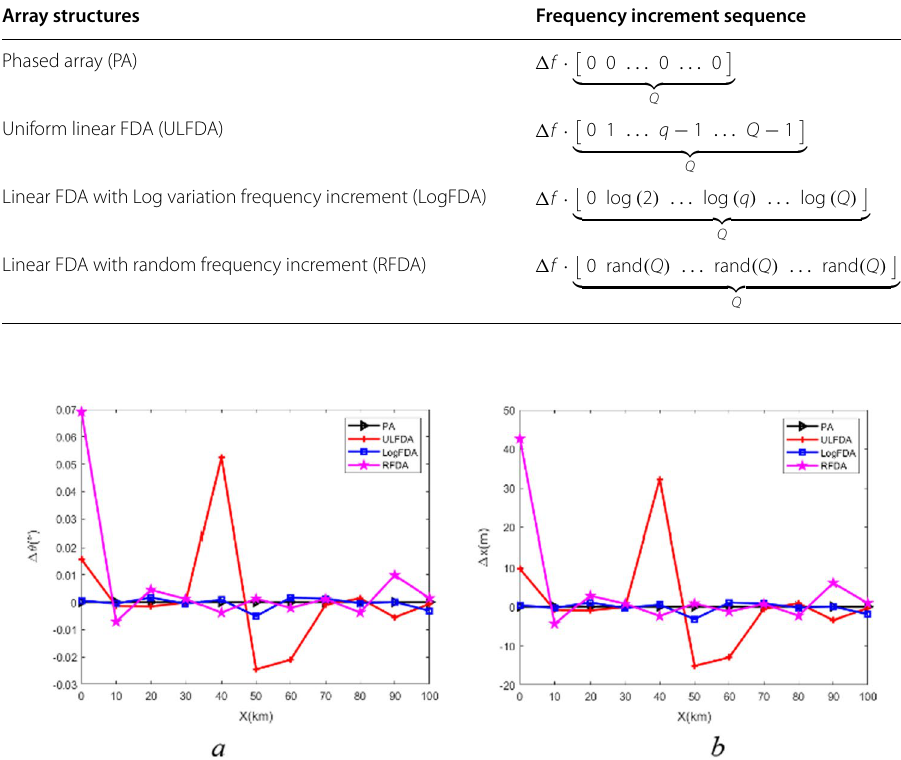
Table 2 Representative antenna linear arrays